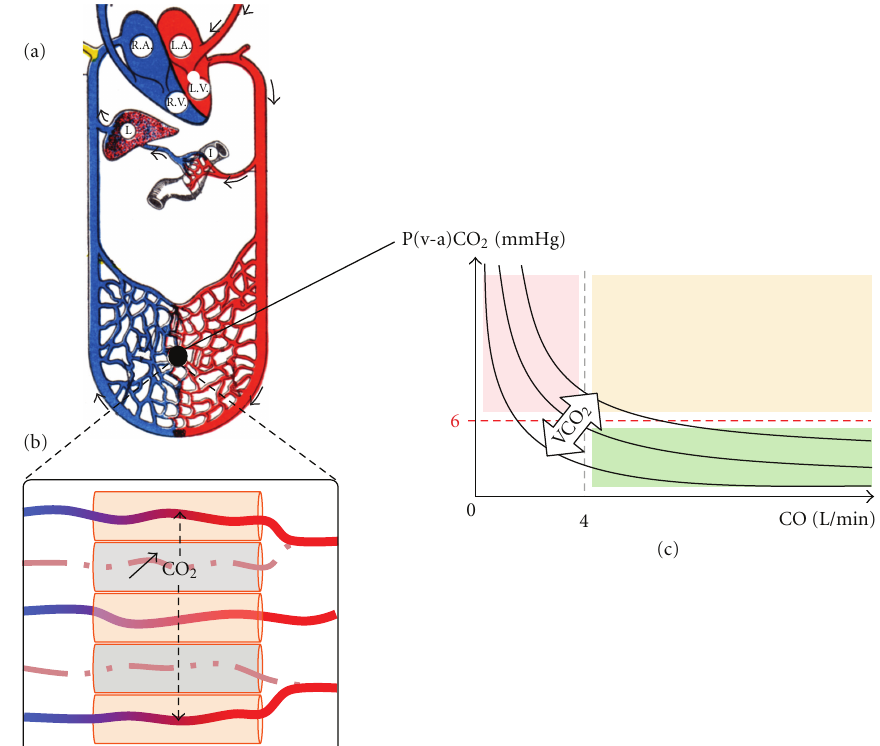
Figure 2: Venoarterial PCO 2 gradient: relationship to cardiac output and capillary hypoperfusion. (a) Schematic representation of the circulation (arterial in red, venous in blue, R.A: right atrium, L.A: left atrium, R.V: right ventricle, L.V: left ventricle, I: intestine, L: liver) and a generic capillary bed. (b) Schematic representation of both a hypoperfused capillaries (dashed lines) and normally perfused capillaries (continuous lines) receiving increased perfusion redistributed from the hypoperfused capillary. CO 2 builds up in the tissue adjacent to hypoperfused capillaries (gray cylinders). Due to its highly di ff usible nature, accumulated CO 2 from hypoperfused tissue di ff uses to tissue adjacent to perfused capillaries which successfully “washout” this increased amount of CO 2 leading to higher venous PCO 2 than normal and therefore a venoarterial PCO 2 gradient, P(v-a)CO 2 , higher than the upper norm of 6mmHg. (c) Relationship between P(v-a)CO 2 and cardiac output (CO). P(v-a)CO 2 decreases along an isopleth for a given metabolic production of CO 2 (VCO 2 ). For “normal” cardiac outputs over 4L/min and normal VCO 2 (green area), P(v-a)CO 2 remains under the upper threshold of 6 mmHg. Decreased cardiac output below 4L/min leads to increased P(v-a)CO 2 due to insu ffi cient “washout” regardless of capillary perfusion. P(v-a)CO 2 increases over 6mmHg in conditions of adequate cardiac output, and normal VCO 2 is pathological and reflects capillary hypoperfusion (o ff -isopleth orange